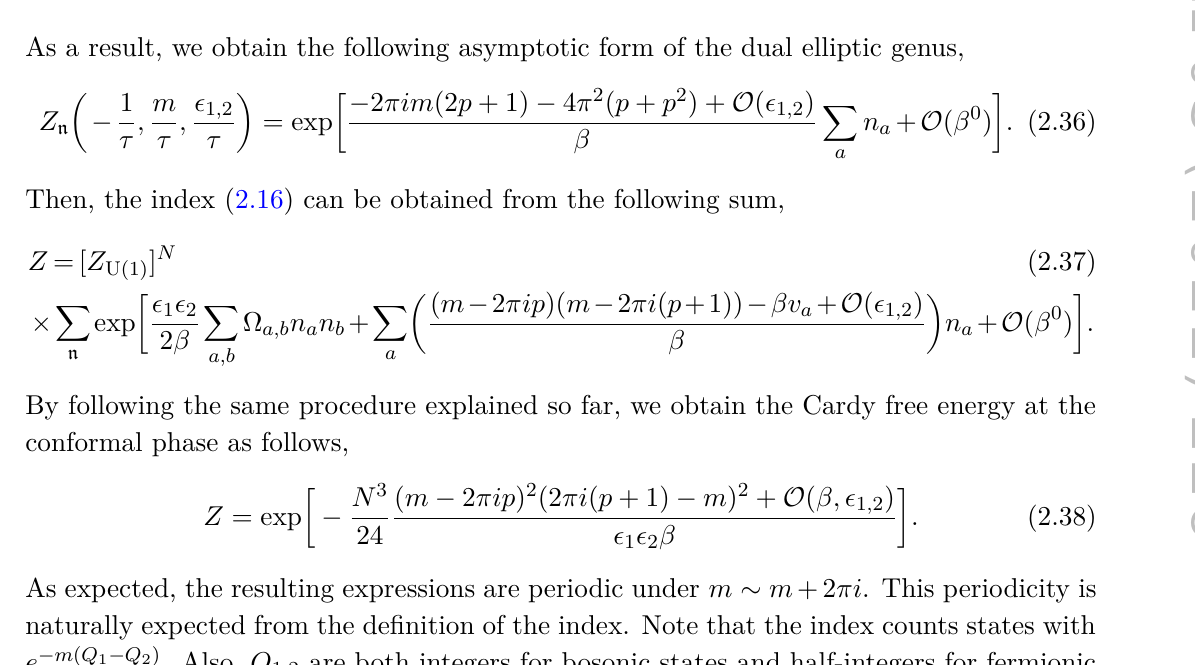
Figure 5. Cardy free energy of the 6d (2,0) theory at the conformal phase. The yellow line is the free energy inside the canonical chamber where the expression (2.26) is